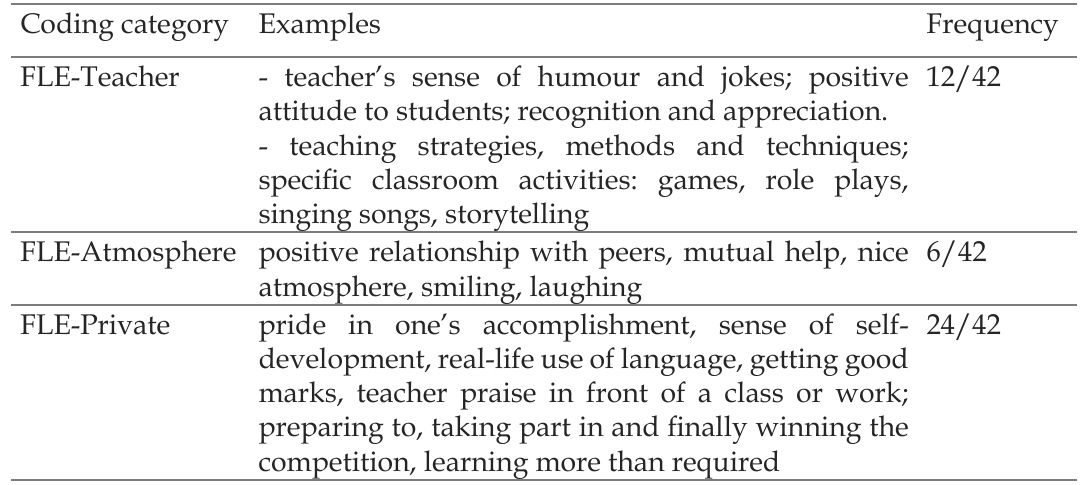
Sources of teachers’ personal learning enjoyment, examples and frequency of mentions by the participants